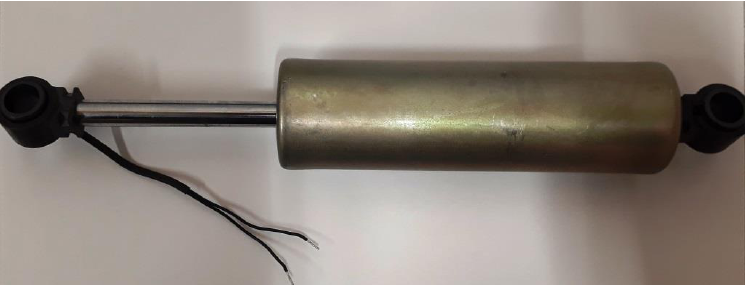
Figure 13. Mechanical structure of a magnetorheological damper, type RD-8041-1, manufactured by Lord